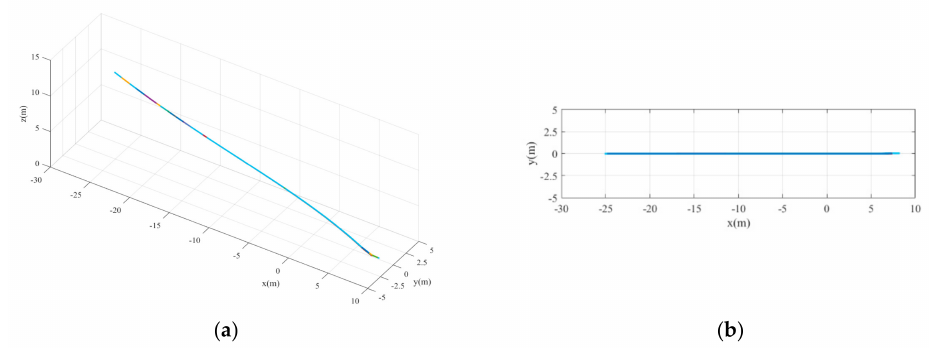
Figure 10. The landing trajectories under case 1. ( a ) 3D trajectory. ( b ) 2D trajectory in the x - y plane.